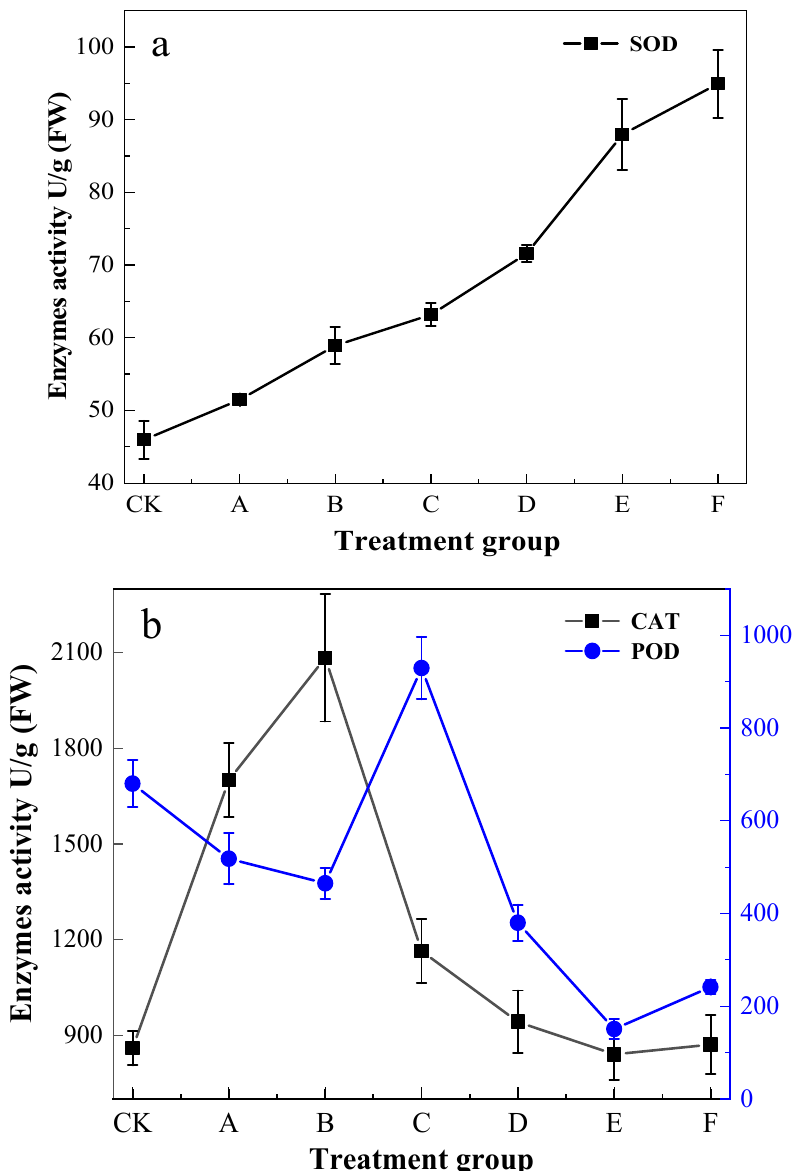
Figure 2. Effects of Pb stress on antioxidant enzymes activity in leaf blades. ( a ) SOD, ( b ) CAT and POD.